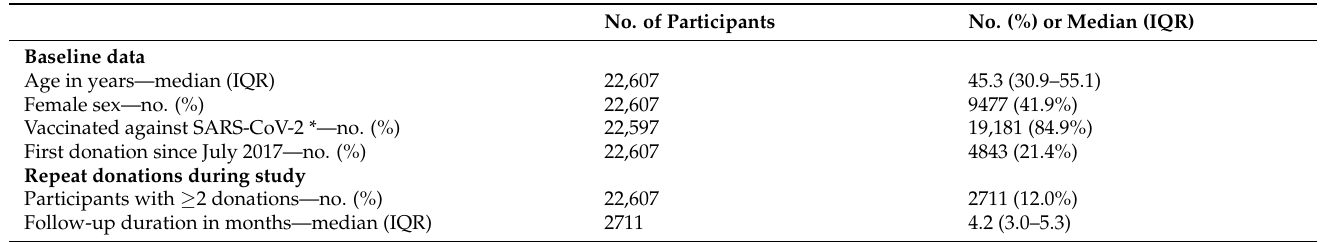
Table 1. Characteristics of participants enrolled in our study; Tyrol, Austria; October 2021–April 2022 ( n =